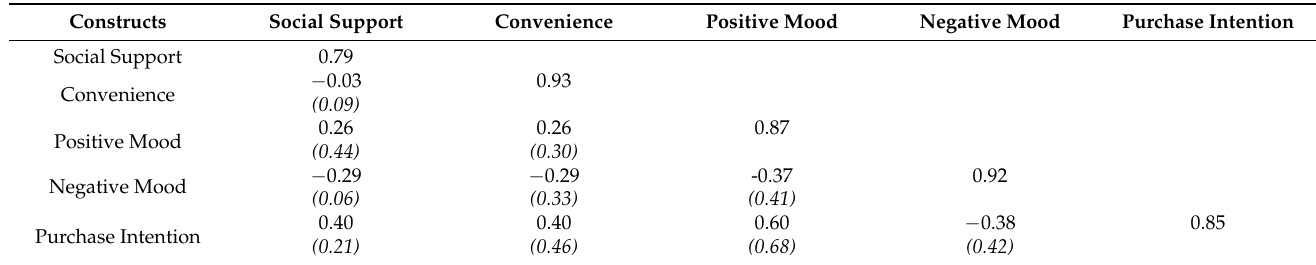
Table A6. Discriminant validity results for openness to experience